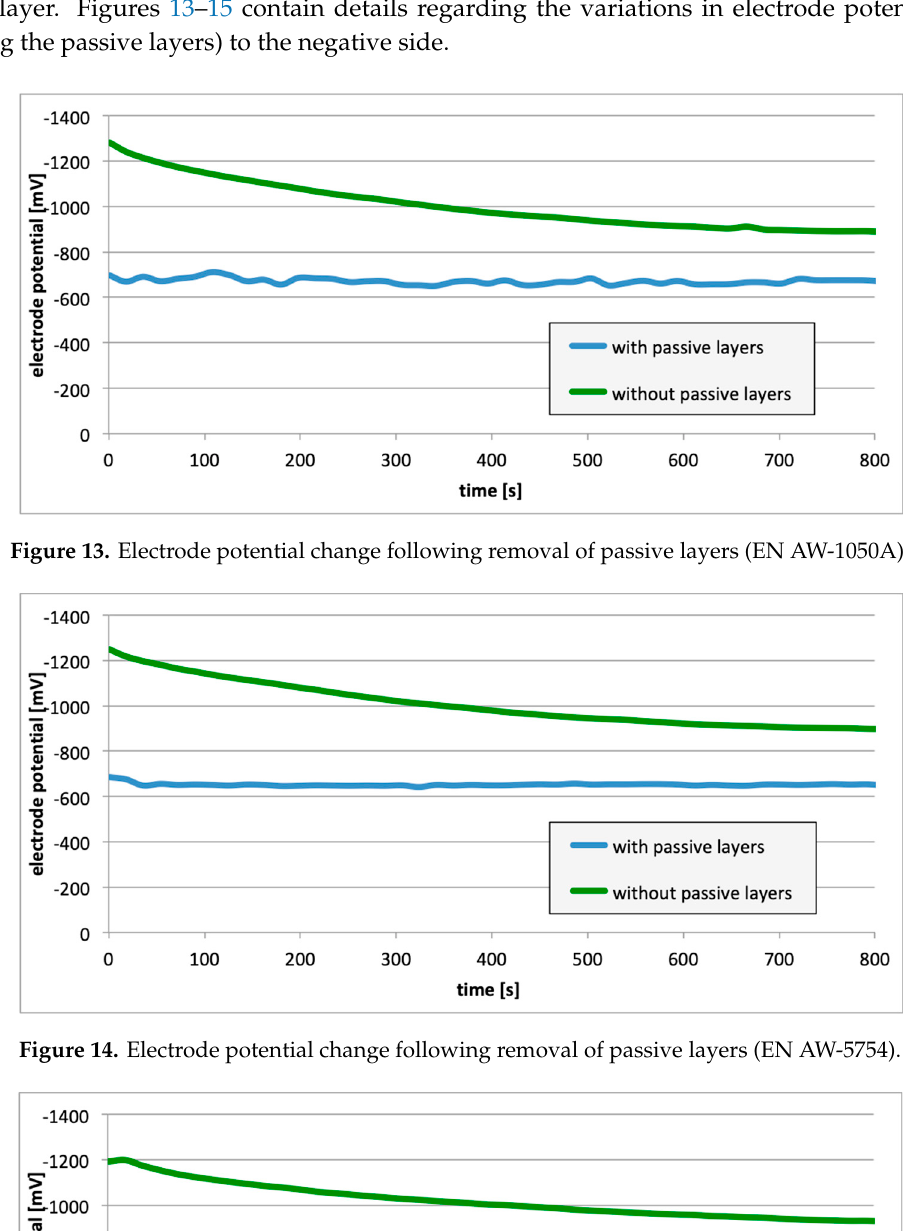
Figure 12. Decrease of cell EMF in time accompanying hydrogen desorption (EN AW-6060). Hydrogenation time: 5, 15, and 25 min.